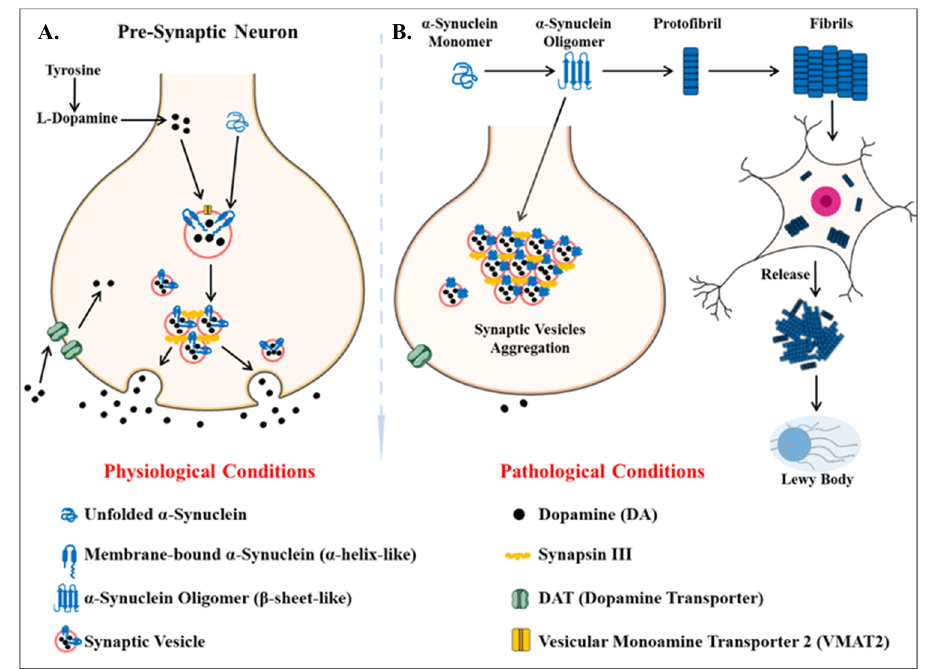
Figure 4. Key differentiation in the normal physiological state and pathological state of dopamine metabolism and homeostasis of alpha-synuclein protein ( α -syn) ( A ) the normal physiological state: Homeostasis of alpha-synuclein protein maintained ( B ) the perturbations in alpha-synuclein homeostasis as well interneuronal aggregation of α -syn oligomer and formation of lewy